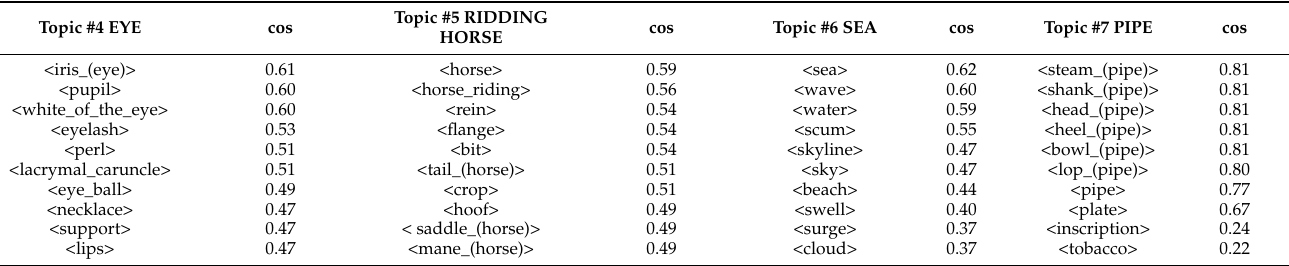
Table 2. Topics in the annotations of Magritte’s artworks and the top 10 nearest descriptors. J.F. Chartier et al. A Data-Driven Computational Semiotics: The Semantic Vector Space of Magritte’s Artworks. Semiotica 2018 , 2019 (230), 19–69 (31,